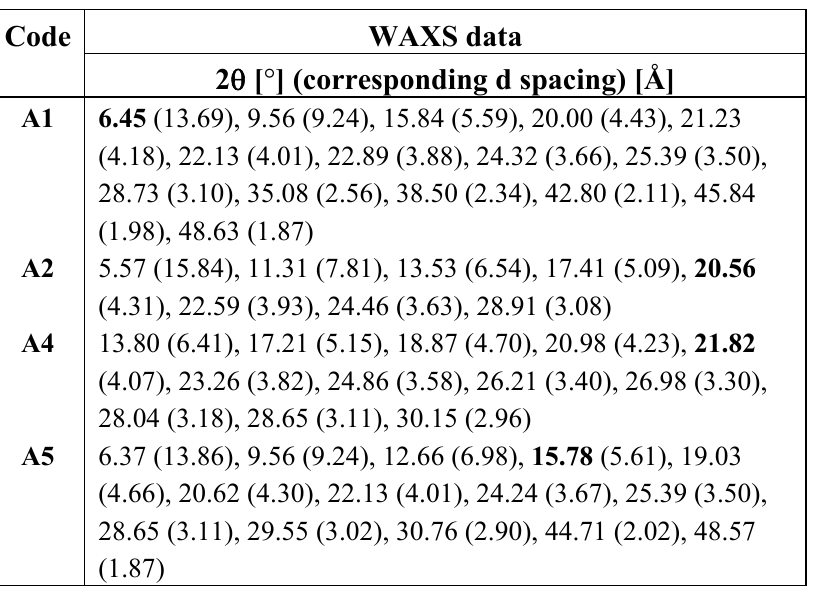
Table 3. WAXS data for the azomethines A1 - A5